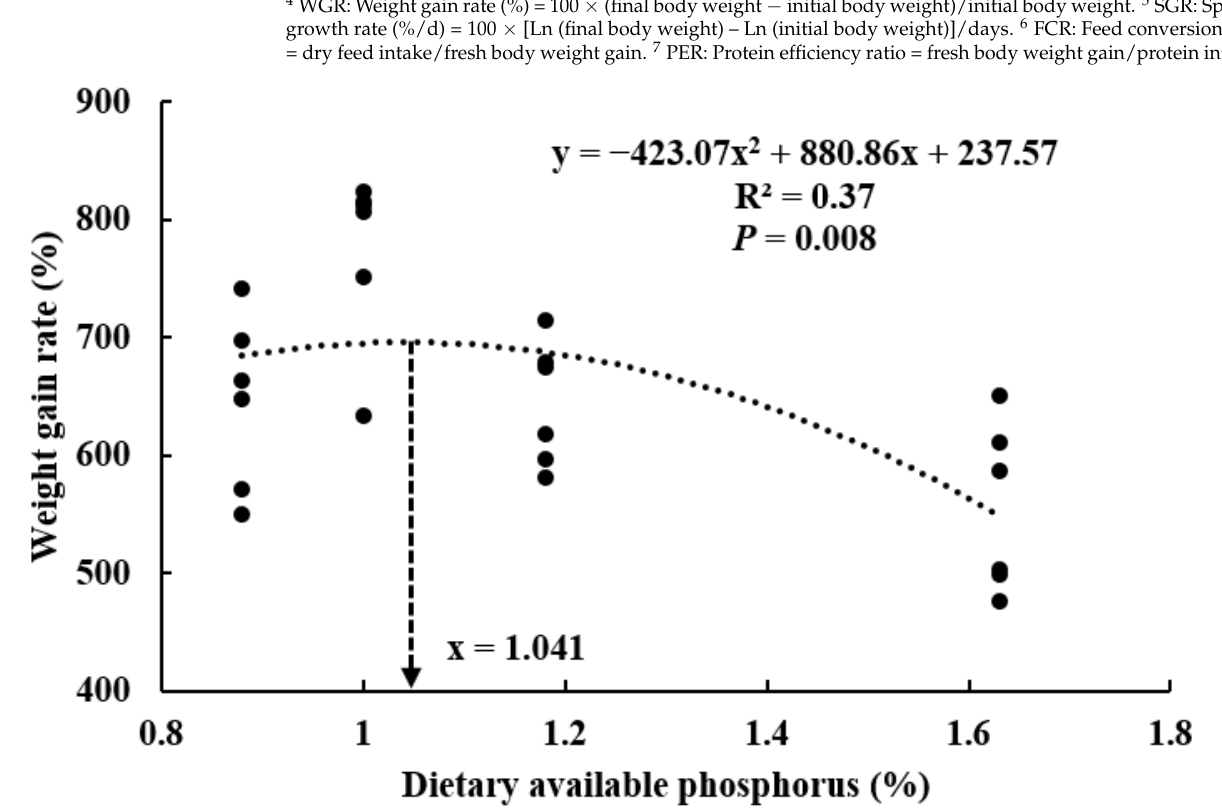
Figure 2. Quadratic regression relationship of weight gain rate against dietary available phosphorus levels.